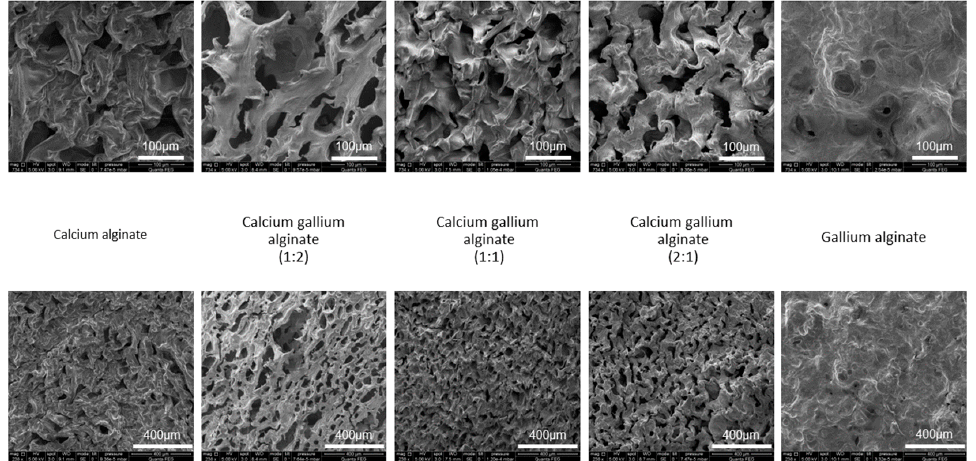
Figure 2. Scanning electron microscopy images of various alginate combinations. Top images: ×734 magnification, lower images: ×238